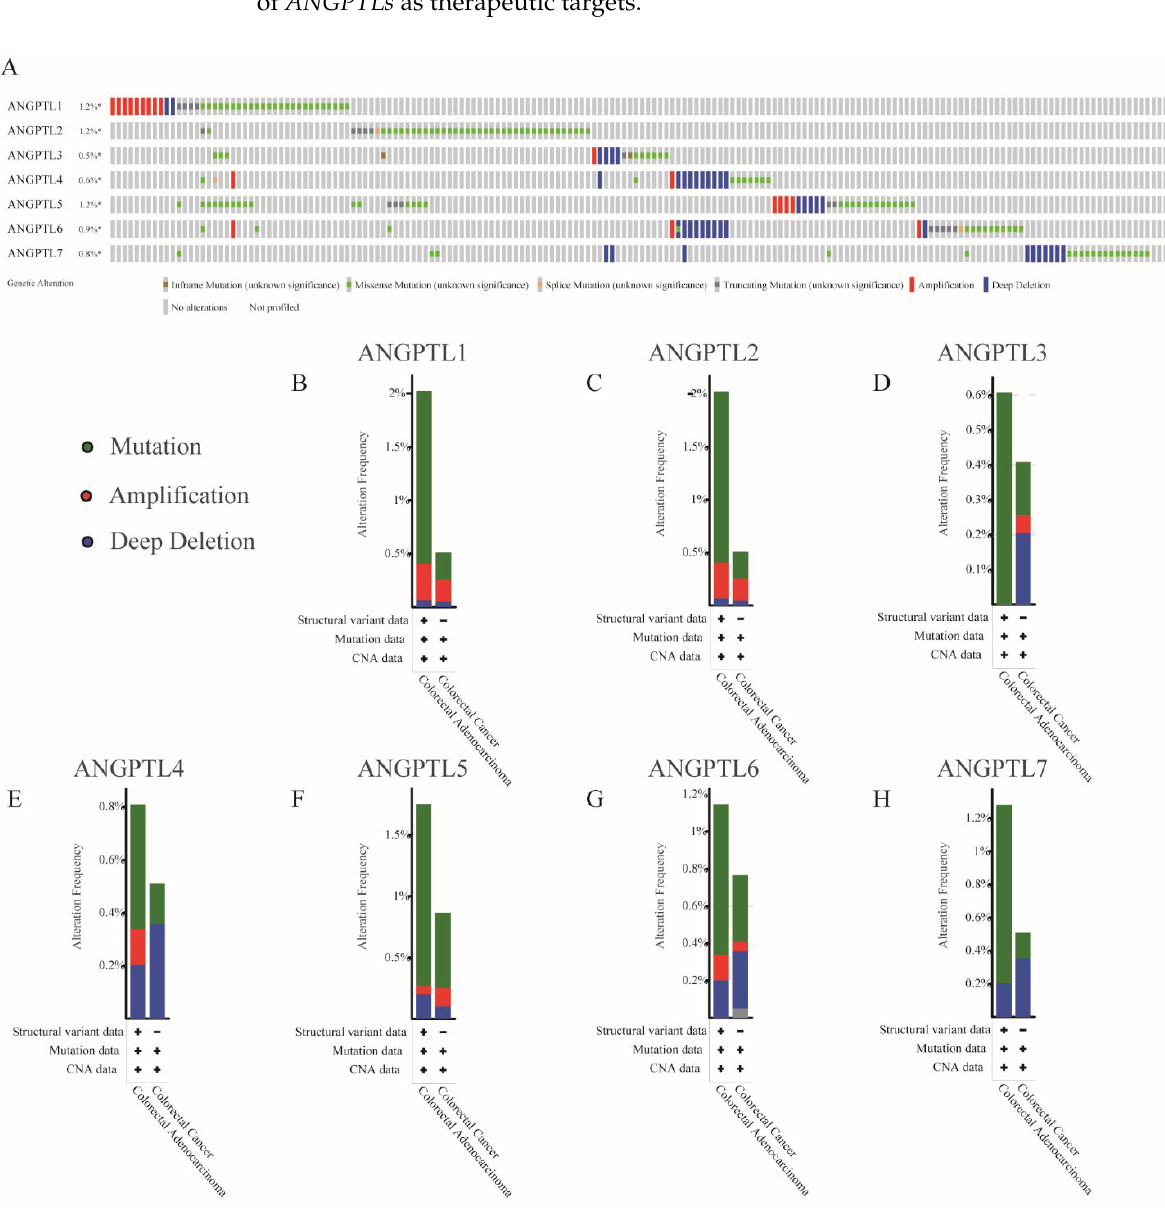
Figure 4. Genetic alterations of ANGPTLs in CRC (cBioPortal). ( A ) Summary of alterations of ANGPTLs in colorectal cancer, * represent the sample rate can represent the overall rate statistically. ( B – H ) Genetic alterations of seven ANGPTLs.